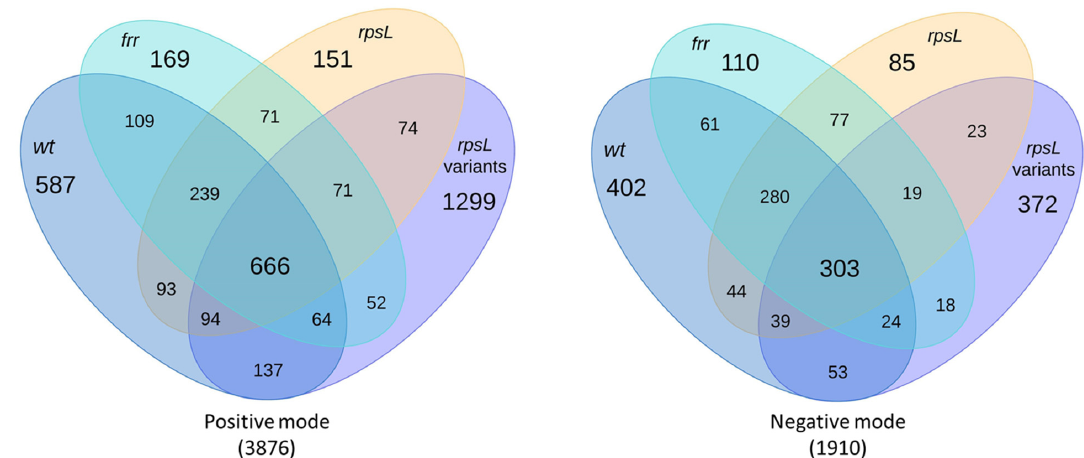
Figure 1. Overview of the numbers of spectral features detected in wild-type S. clavuligerus (wt) and strains overexpressing frr , rpsL , or rpsL variants (K88E, L90K, and R94G), respectively. The total number of spectral features detected in each ionization mode is indicated in parentheses.